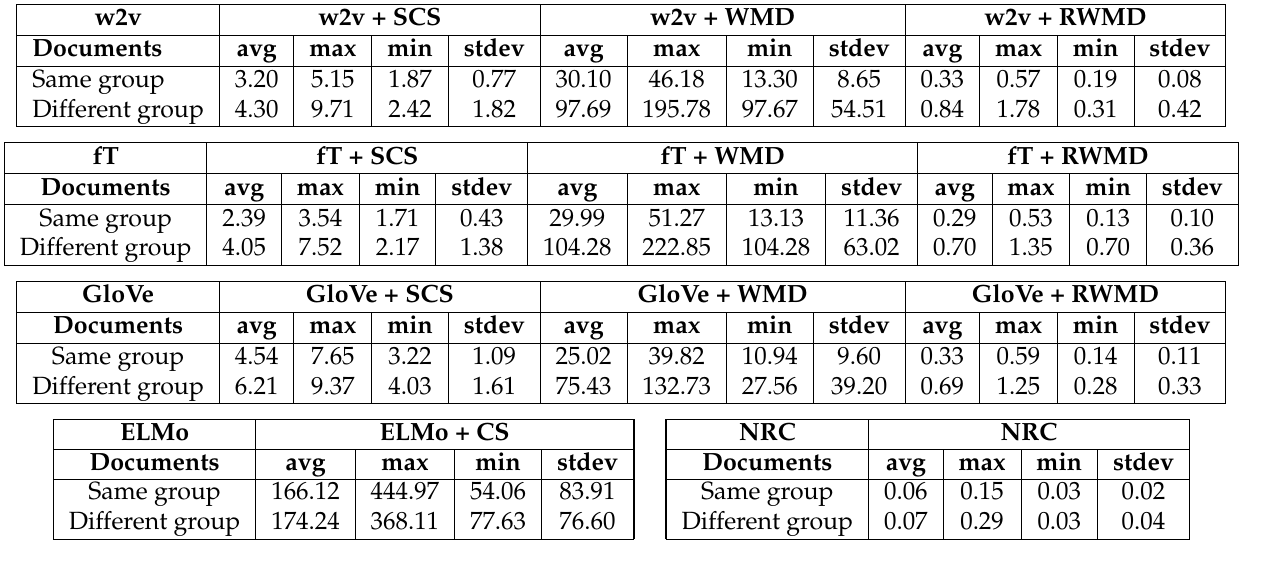
Figure 1. Time performance (in seconds) of the different similarity measures when evaluating papers belonging to the same (third row of each table) research group and different ones (fourth row) with the different strategies. The timings include the calculation of the embeddings when necessary and the similarity measurement. Table 4. Mean and standard deviation for computation times for the different combinations with Ph.D.